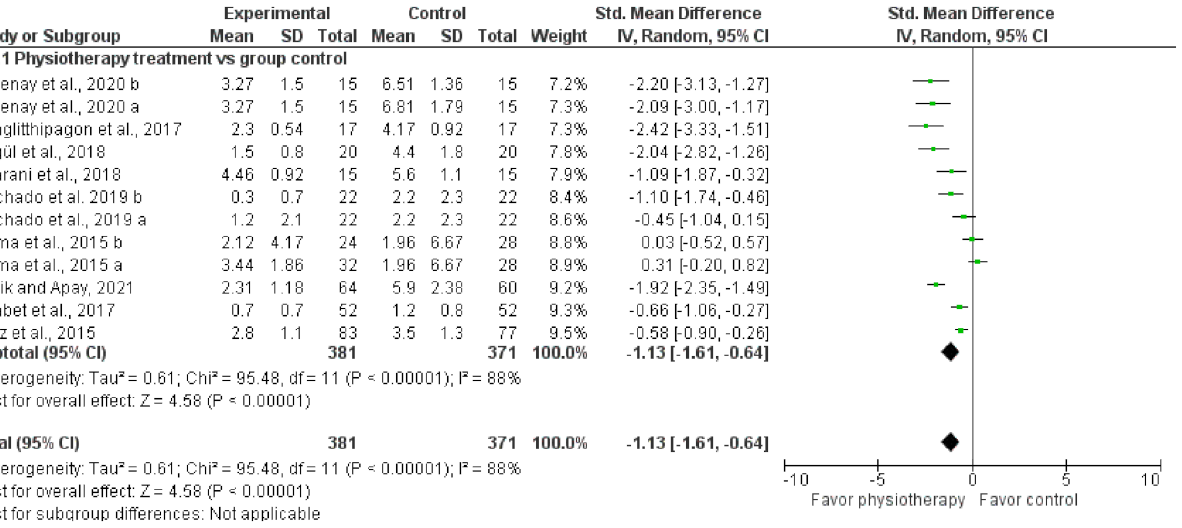
Figure 3. Pooled MD (95% CI) of effect of physiotherapy in pain relief.